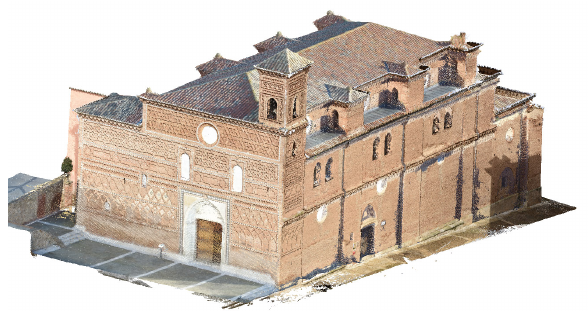
Figure 4. Final 3D point cloud of the Santa Mar´ıa church (Tobed, Spain).